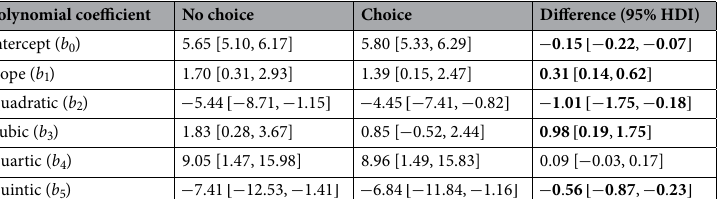
Table 2. Summary of the estimated coefficients (with 95% HDIs) of the polynomial for the choice and no-choice conditions, along with the estimated difference (95% HDI) between conditions for Experiment 2. Coefficients are standardized to make the scales comparable—raw coefficients can be obtained by dividing b n by the standard deviation of the time points for the corresponding term, SD ( t ◦ between choice and no-choice conditions that exclude zero are highlighted in